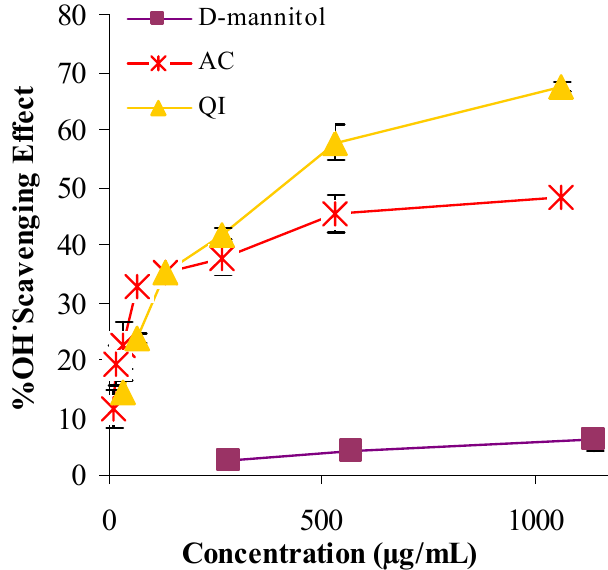
Figure 3. Hydroxyl radical scavenging activity of test samples (AC and QI) and the positive reference ( D -mannitol) were spectrophotometrically measured at 532 nm using the deoxyribose